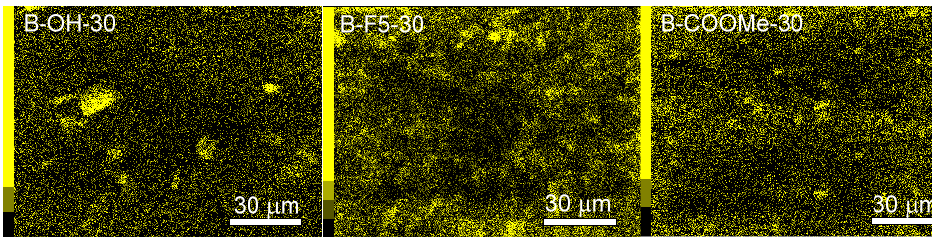
Figure 5. SEM EDS Si mapping of PLA/PMMA blends modified with LPSQ-R.